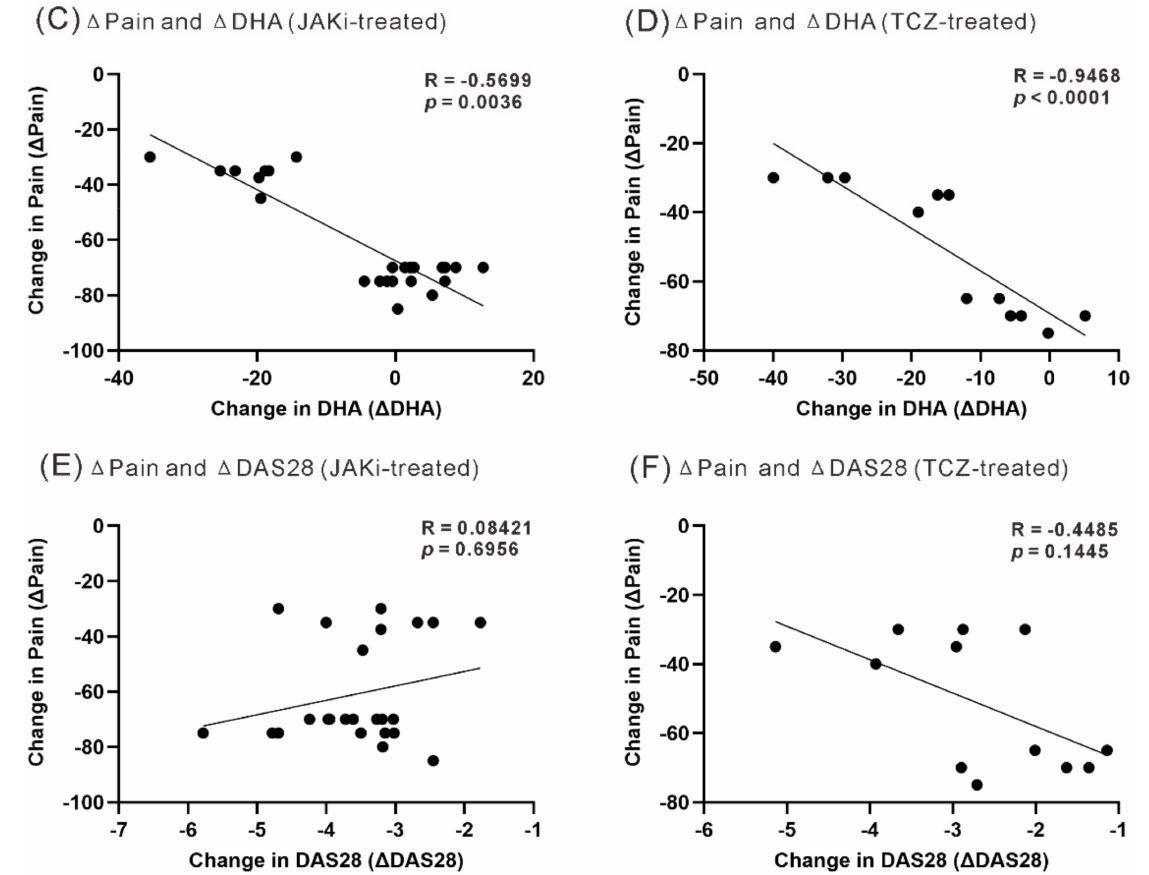
Figure 4. The correlation between DHA levels and pain scores after treatment or between pain decrement and the change of DHA levels or DAS28 scores. The correlation between serum DHA levels and pain scores assessed at week 24 in ( A ) JAKi-treated or ( B ) TCZ-treated patients. The correlation between the decrement of pain scores and the change of DHA levels in ( C ) JAKi-treated or ( D ) TCZ-treated patients. The correlation between the decrement of pain scores and the decrement of disease activity (DAS28 scores) in ( E ) JAKi-treated or ( F ) TCZ-treated patients. The correlation coefficient (R-value) was calculated using the nonparametric Spearman’s rank correlation test. JAK: Janus kinase inhibitors; TCZ: tocilizumab; DAS28: disease activity score for 28-joints.